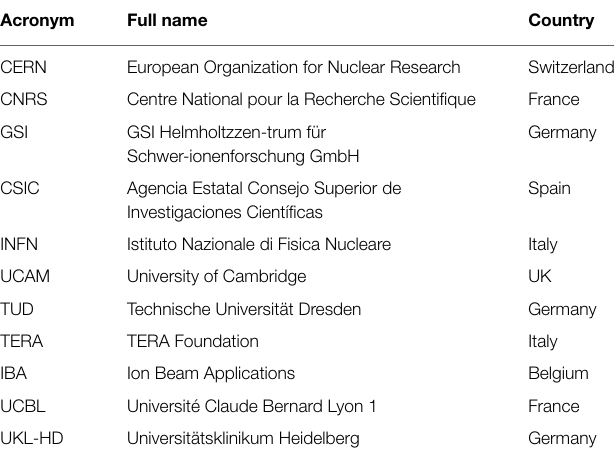
TABLE1 | ENTERVISIONpartners:thistableliststheInstitutes,Universities, and companies participating to ENTERVISION .